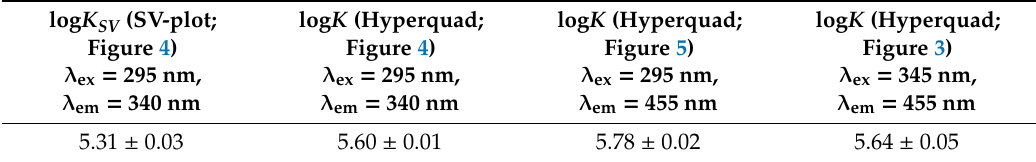
Table 1. Binding constants determined by the three methods show good correlation and suggest the formation of stable AOH-HSA complexes. Table 1. Decimal logarithmic values of Stern-Volmer quenching constant ( K SV ; unit: L / mol) and binding constants ( K ; unit: L / mol) of AOH-HSA complex. Data represent mean ± SEM ( n = 3). log K SV